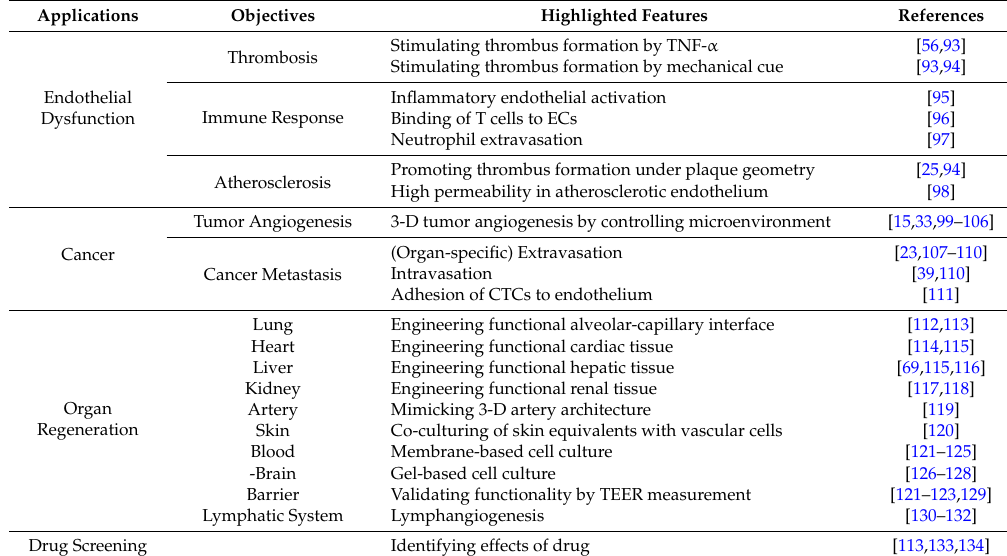
Table 1. Summary of applications using engineered